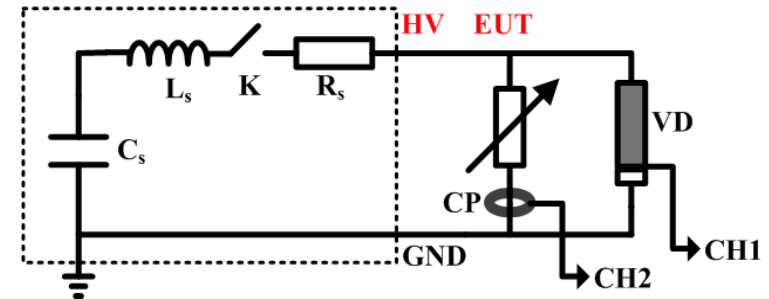
Figure 1. The equivalent circuit for the experimental setup.